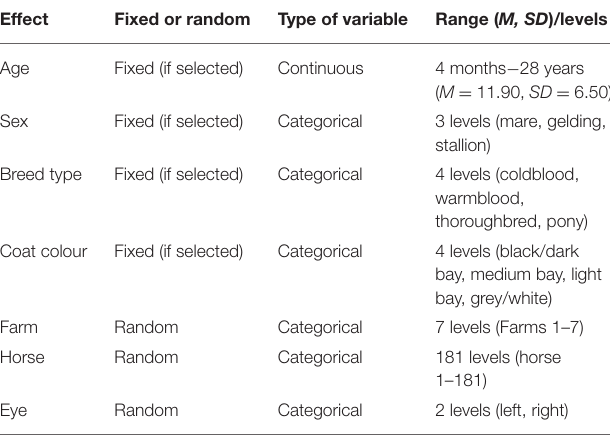
TABLE 2 | Overview of all fixed and random effects, whether they were treated as continuous or as categorical variables, as well as their ranges [mean ( M ), standard deviation ( SD )] for continuous variables and their levels for categorical